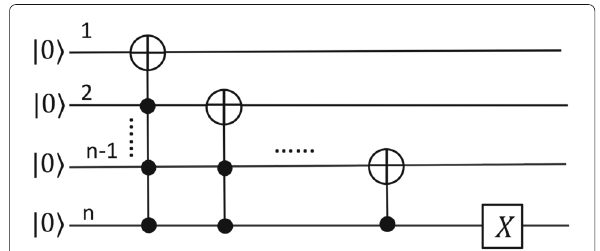
Fig. 5 Decomposition of operator E 1 in the form of basic